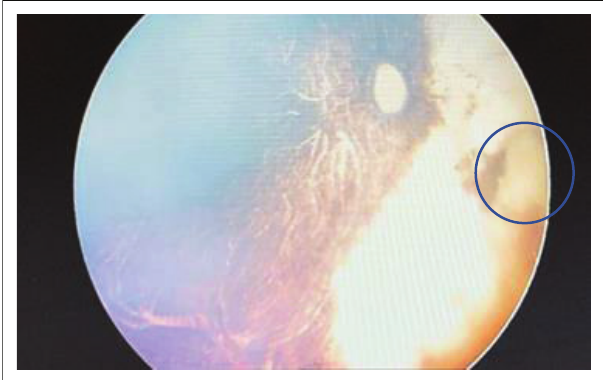
FIGURE 1: RetCam photo of the left eye showing areas of chorioretinal atrophy (Type 4 regression) and an area of concern for reactivation within the circle.